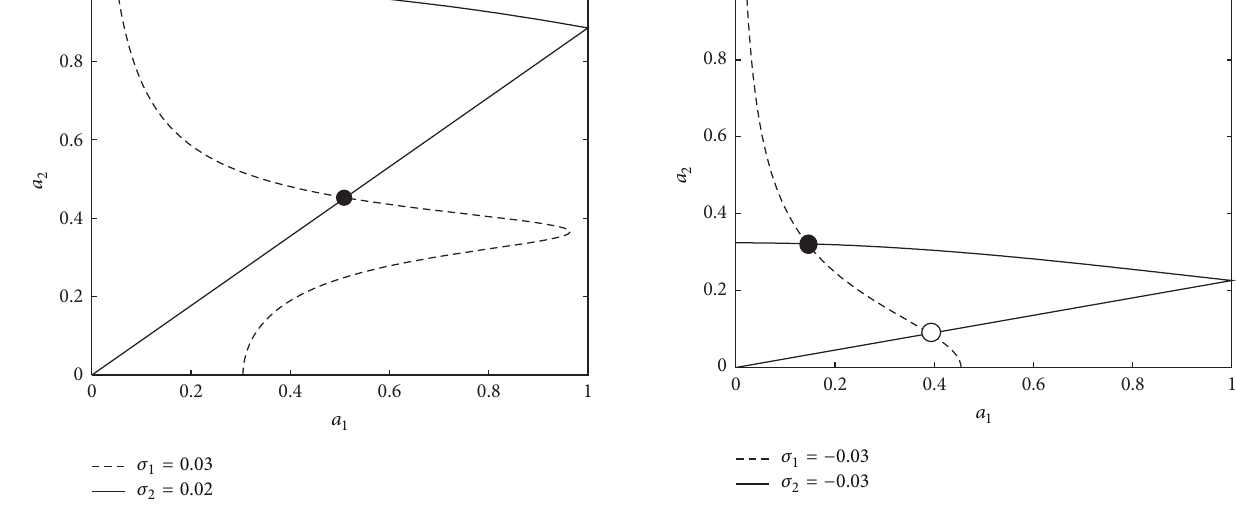
Figure 5: Steady-state solution when 𝜎 1 = 𝜎 2 = −0.03 [rad ⋅ s −1 ].